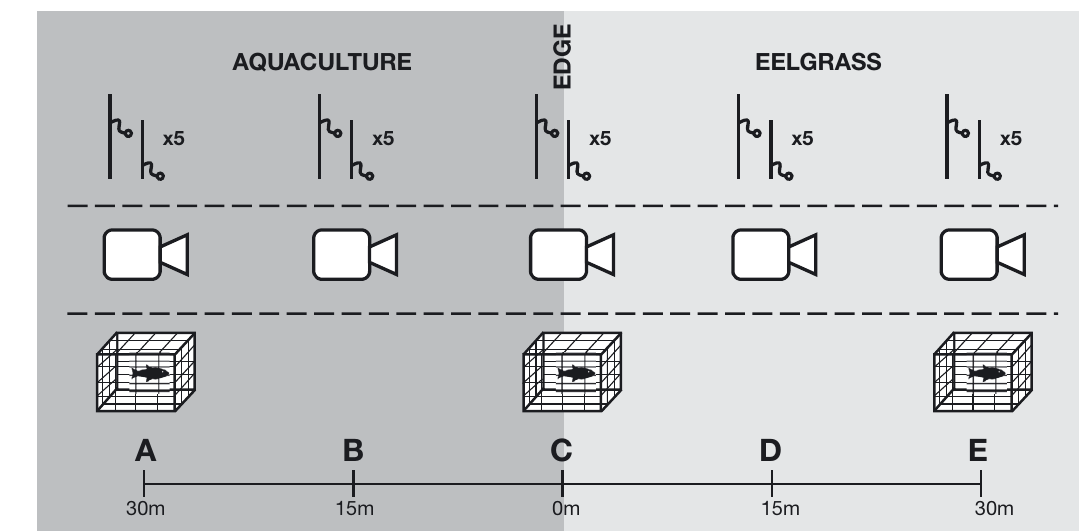
Fig. 2. Sampling design showing predation tethering units (top), cameras (middle), and minnow traps (bottom). Letters refer to main habitat points along the transect (A: aquaculture interior; B: aquaculture intermediate; C: edge; D: eelgrass intermediate; E: eelgrass